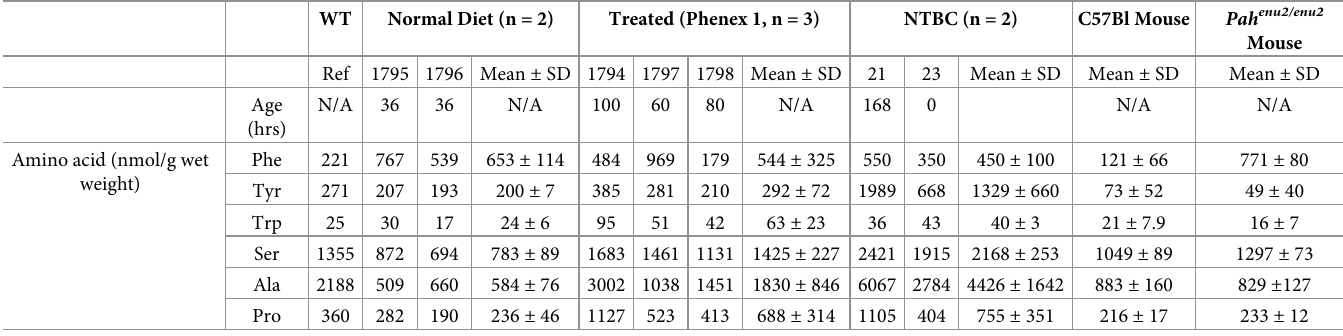
Table 2. Brain amino acid profiles in PAH R408W/R408W piglets.